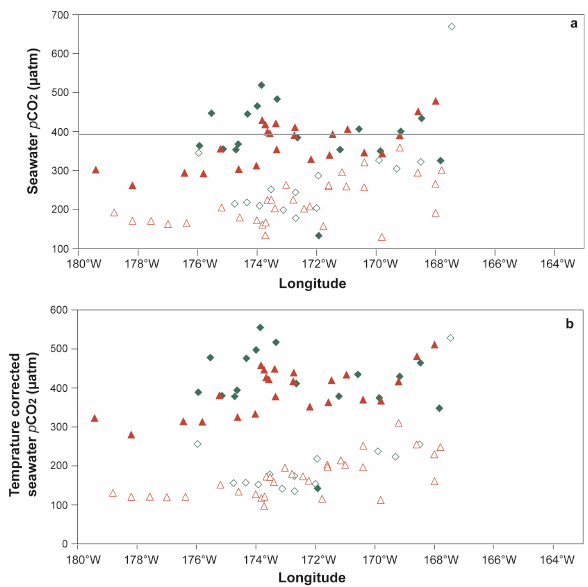
Figure 8 . Surface seawater p CO 2 (panel a ) and temperature corrected seawater p CO 2 (panel Fig. 8. Surface seawater p CO 2 (panel a ) and temperature corrected b ) plotted against longitude for the northern Bering Sea shelf at the North Line (red symbols) seawater p CO 2 (panel b ) plotted against longitude for the northern and Middle Line (green symbols). Temperature corrected seawater p CO 2 was based on corrected to 0°C using the empirical relationships of Takahashi et al ., 2002. Spring and Bering Sea shelf at the North Line (red symbols) and Middle Line summer data was shown with closed and open symbols respectively. In the panels, the (green symbols). Temperature corrected seawater p CO 2 was based nearshore to offshore transition is shown from right to left (i.e., east to west). on corrected to 0 ◦ C using the empirical relationships of Takahashi et al., 2002. Spring and summer data was shown with closed and 38 open symbols respectively. In the panels, the nearshore to offshore transition is shown from right to left (i.e., east to